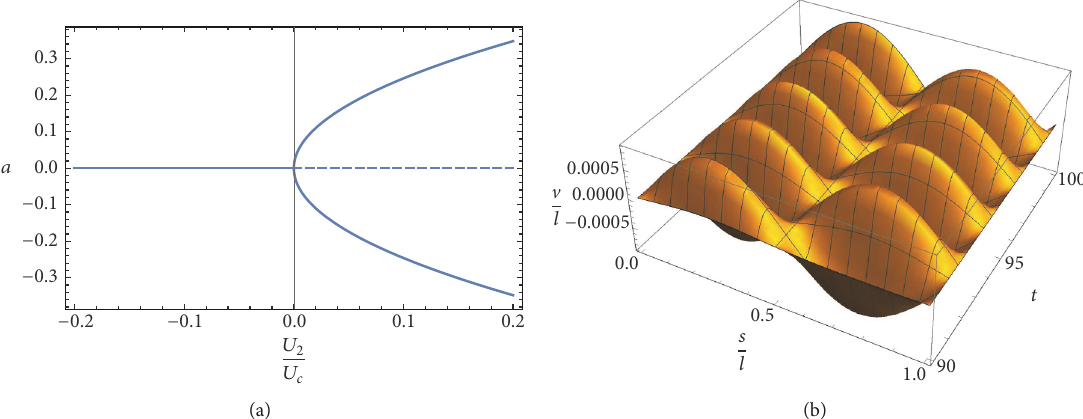
Figure 7: Case-study 2: (a) bifurcation diagram (solid line: stable; dashed line: unstable); (b) reconstituted displacement V (𝑠,𝑡) of the cable for 𝑈 2 /𝑈 𝑐 = 0.09